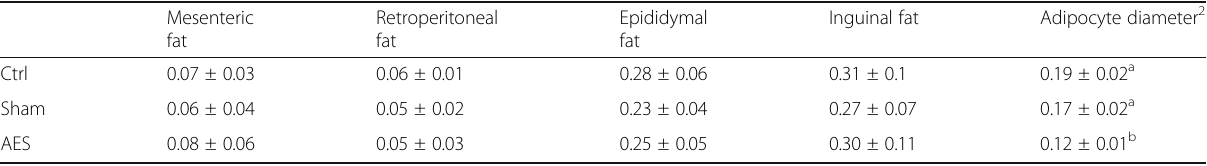
Table 2 Body fat (%) and adipocyte diameter (mm)